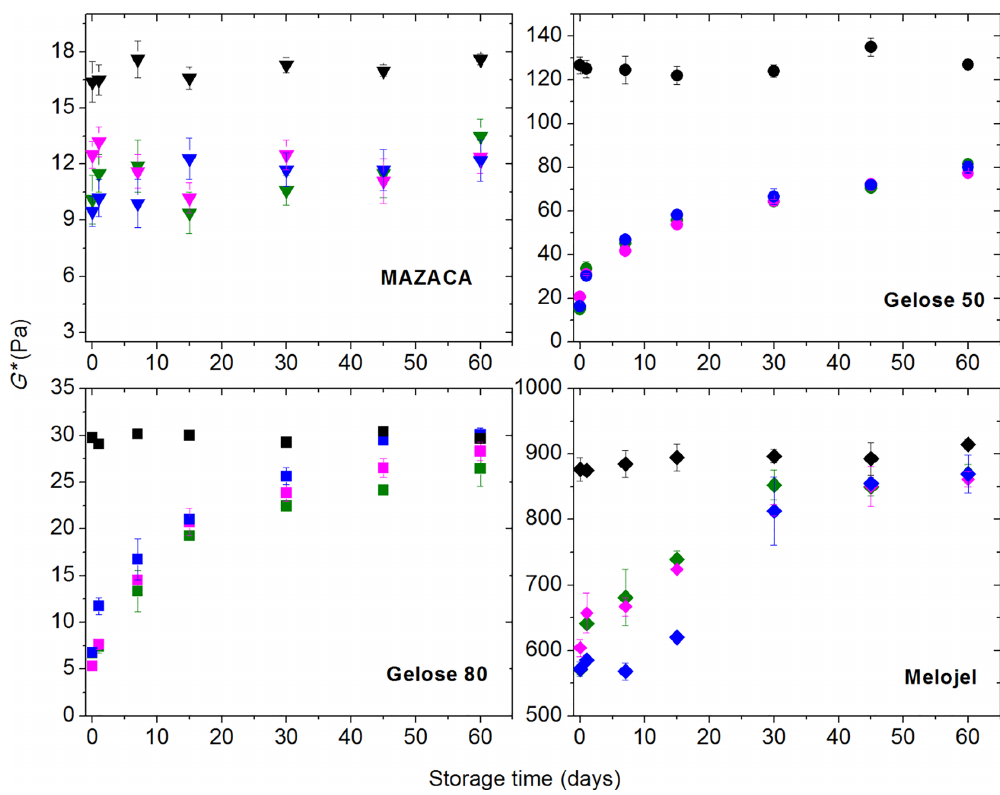
Fig 2. Complex modulus (G * ) at 1 Hz, for Gelose 50, Gelose 80, MAZACA, and Melojel as a function of time for storage starch pastes stored at 4°C. Black: Non-treated control sample, Olive: Pressure releasing rate: 50 MPa/min, Magenta: Pressure releasing rate: 100 MPa/min, Blue: Pressure releasing rate: 900 MPa/min.